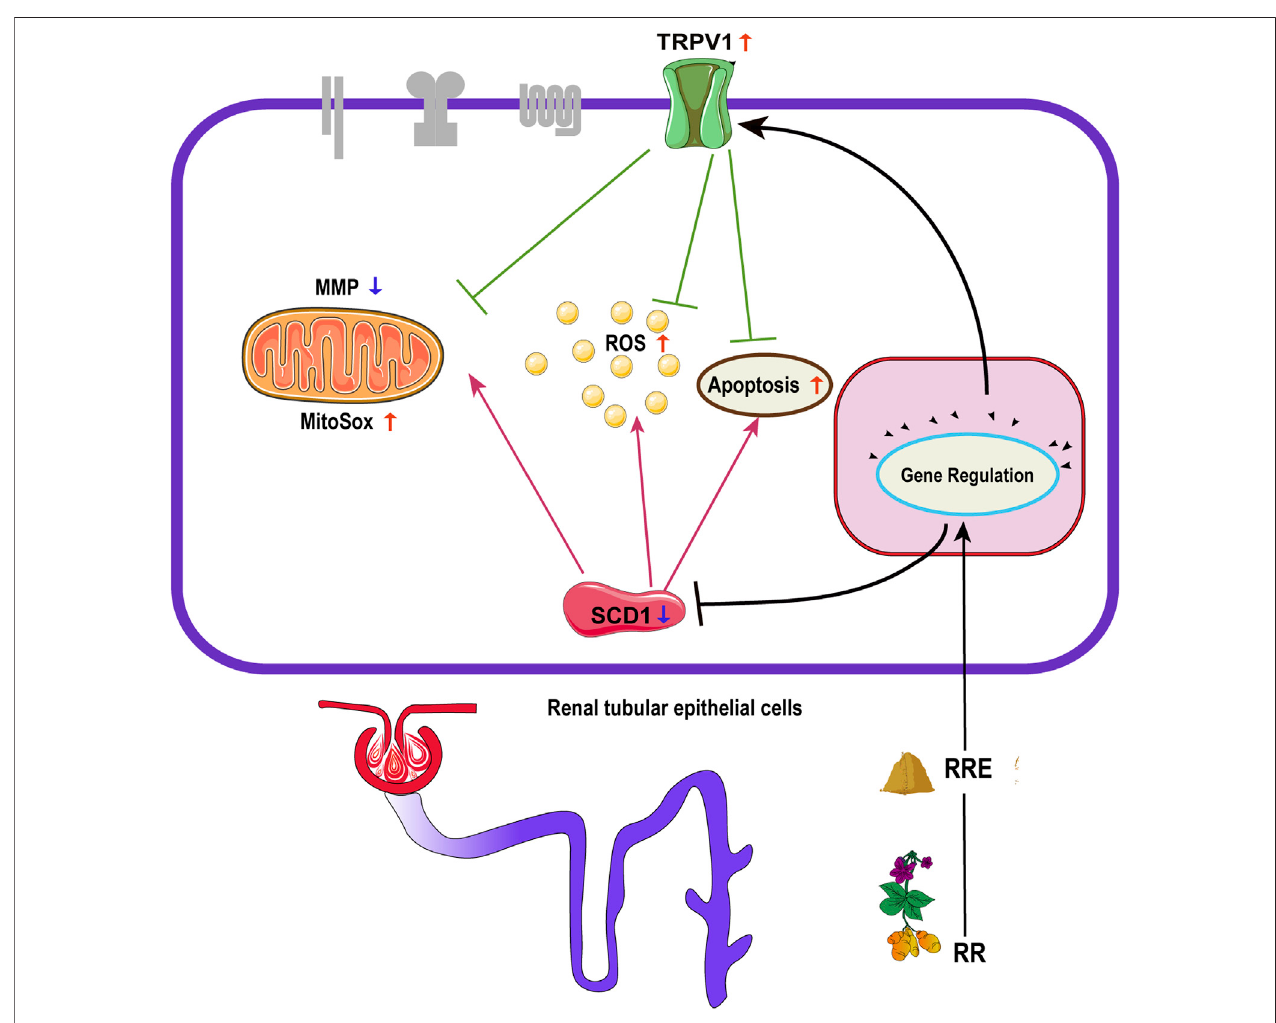
FIGURE 8 | Effect of regulation of TRPV1 and SCD1 by RR on apoptosis, ROS, MitoSOX, and MMP: RR, Rehmanniae Radix; RRE, Rehmanniae Radix extract; TRPV1, transient receptor potential vanilloid 1; SCD1, stearoyl-CoA desaturase 1; ROS, reactive oxygen species; MitoSOX, mitochondrial superoxide; MMP, mitochondrial membrane